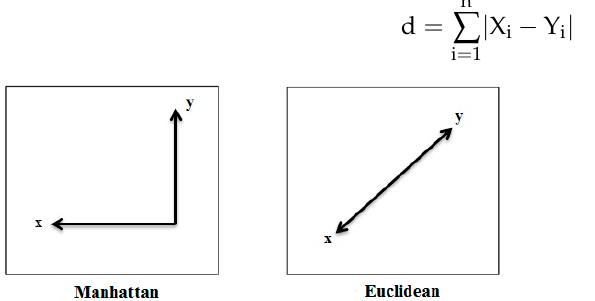
Figure 4. Difference between Manhattan and Euclidean distances in measuring the distance be- tween points x and y . points x and